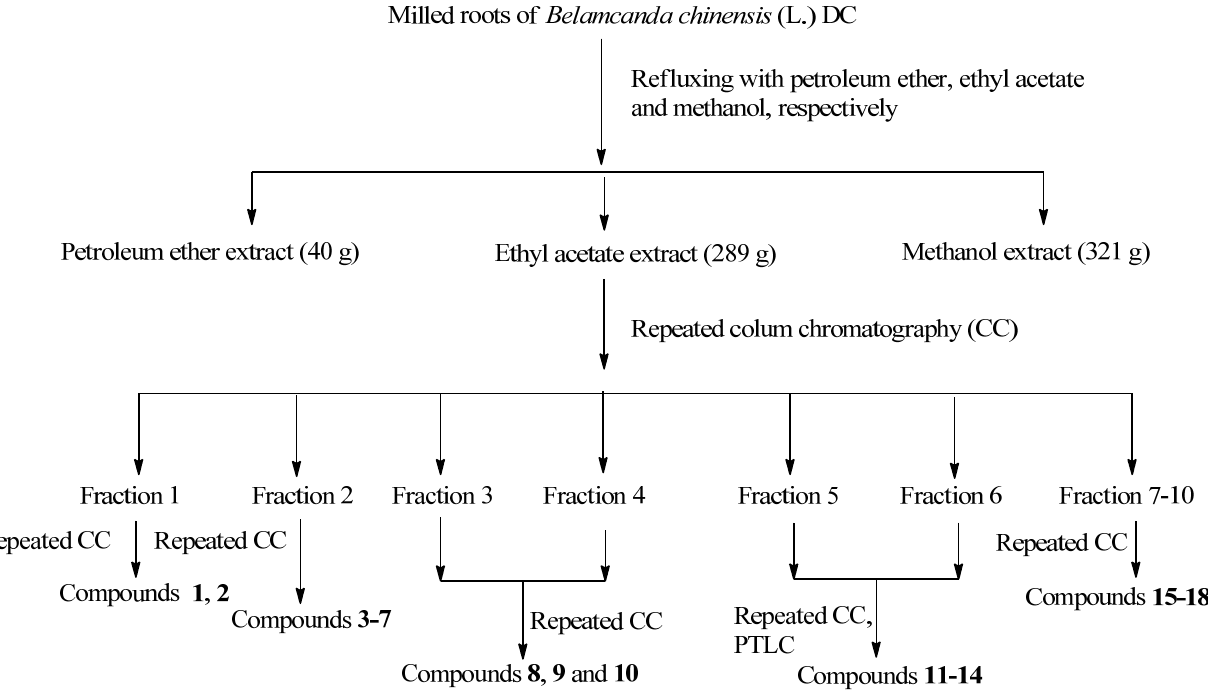
Figure 1. Extraction, fraction, and column chromatography separation of B. chinensis